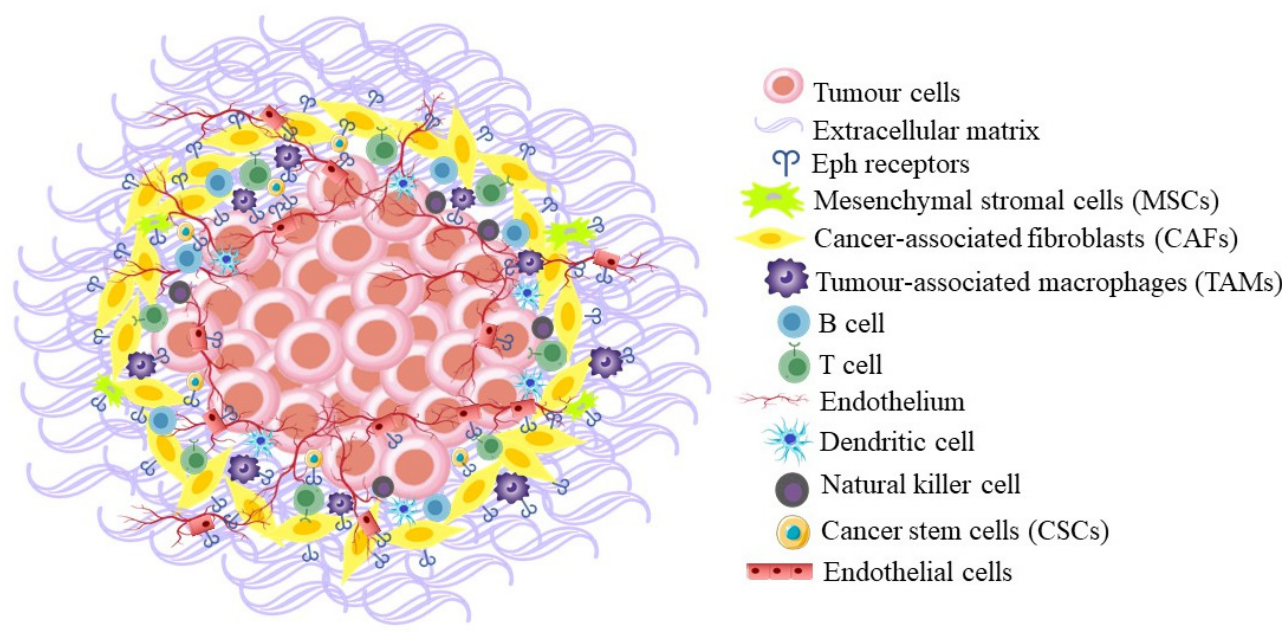
Figure 3. Eph receptors expressed on different cell types in the tumour microenvironment.